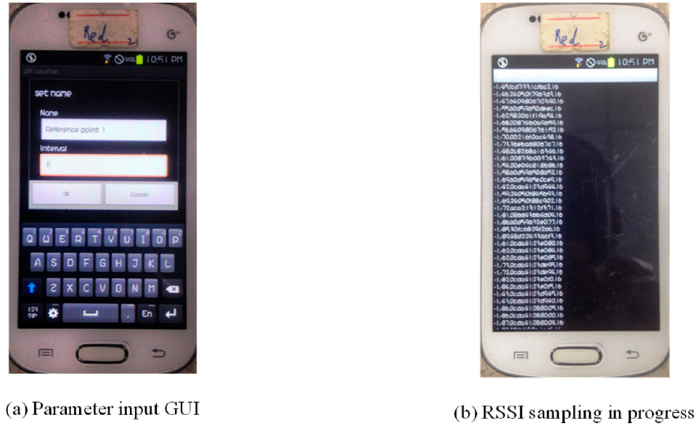
Figure 4. Data acquisition APP. ( a ) GUI interface for parameter input. ( b ) RSSI sampling at RP.